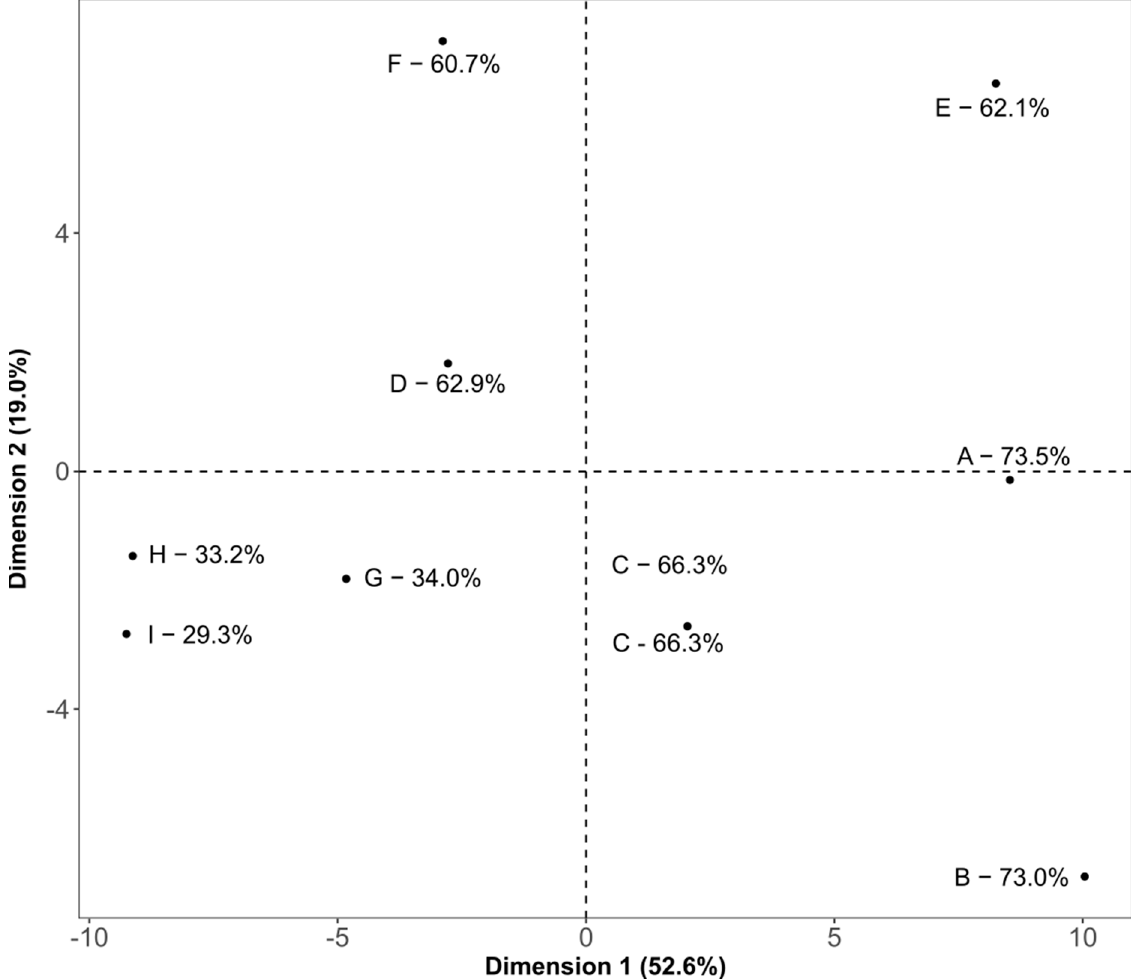
Figure 4. PCA scores plot from the analysis of the peak areas of 96 compounds present in nine new make whisky spirits (percentages next to the sample codes indicate the ABV).